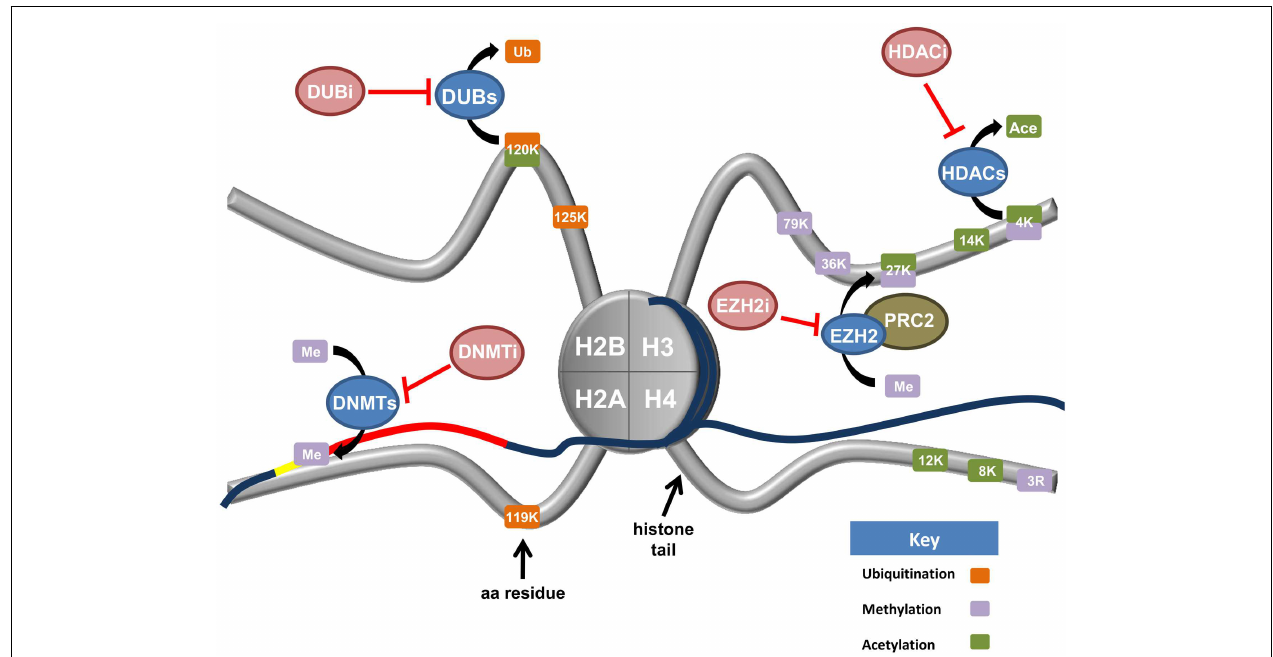
FIGURE 3 | Current and upcoming therapies for the targeting of epigenetic modifiers in ovarian cancer .Tumor suppressor genes are commonly silenced in ovarian cancer through epigenetic writers and erasers (blue ovals).These proteins regulate a variety of modifications including DNA methylation (DNMTs), histone methylation (EZH2), the removal of both histone acetylation (HDACs), and histone monoubiquitination (DUBs).Various inhibiting agents (red ovals) have been designed to stop the action of these enzymes. DNA methyltransferases (DNMTs) silence tumor suppressor genes (red line) by hypermethylation of CpG islands in gene promoters (yellow line). Consequently, DNMT inhibitors (DNMTi) are currently being trialed in ovarian cancer cell models with value in the reactivation of a tumor